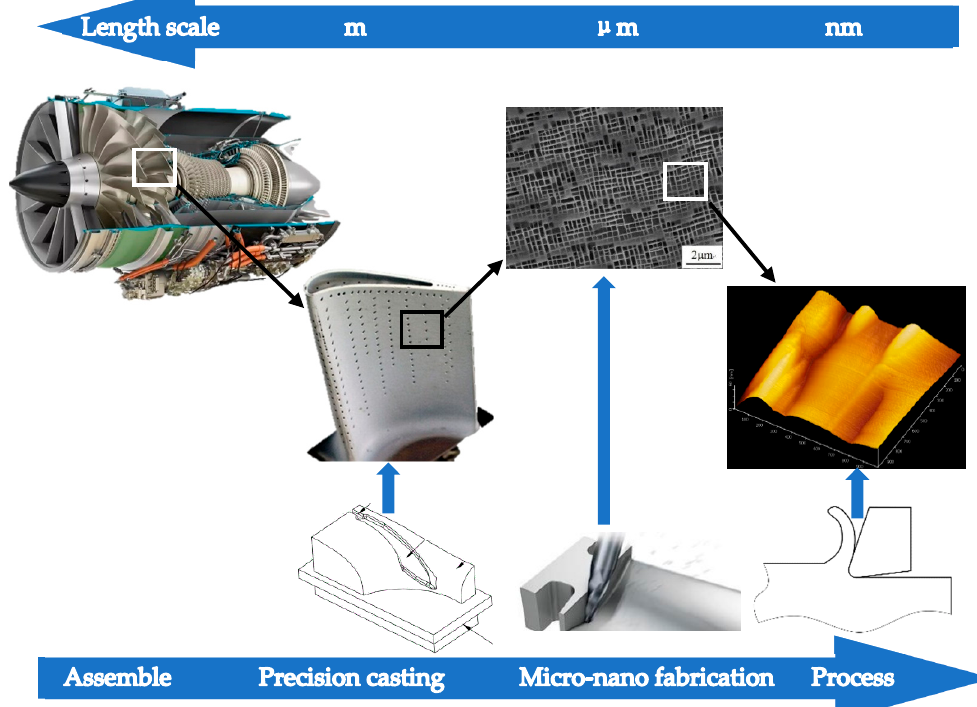
Figure 1. Ultra-precision parts of aero-engines. In the previous study of monocrystalline nickel grinding, it was found that the size of the abrasive grains had a significant influence of surface quality of monocrystalline nickel. The effect of abrasive particle diameter is essentially the reaction of an effective rake angle during processing. Thus, it can be concluded that the size and shape of the machining tool will affect the workpiece even when the size range is small to the nanometer level. Therefore, this study discusses the nanofabrication of tools with different rake angles, different clearance angles, and different tool edge radii, and their impact on the processing mechanism of monocrystalline nickel.